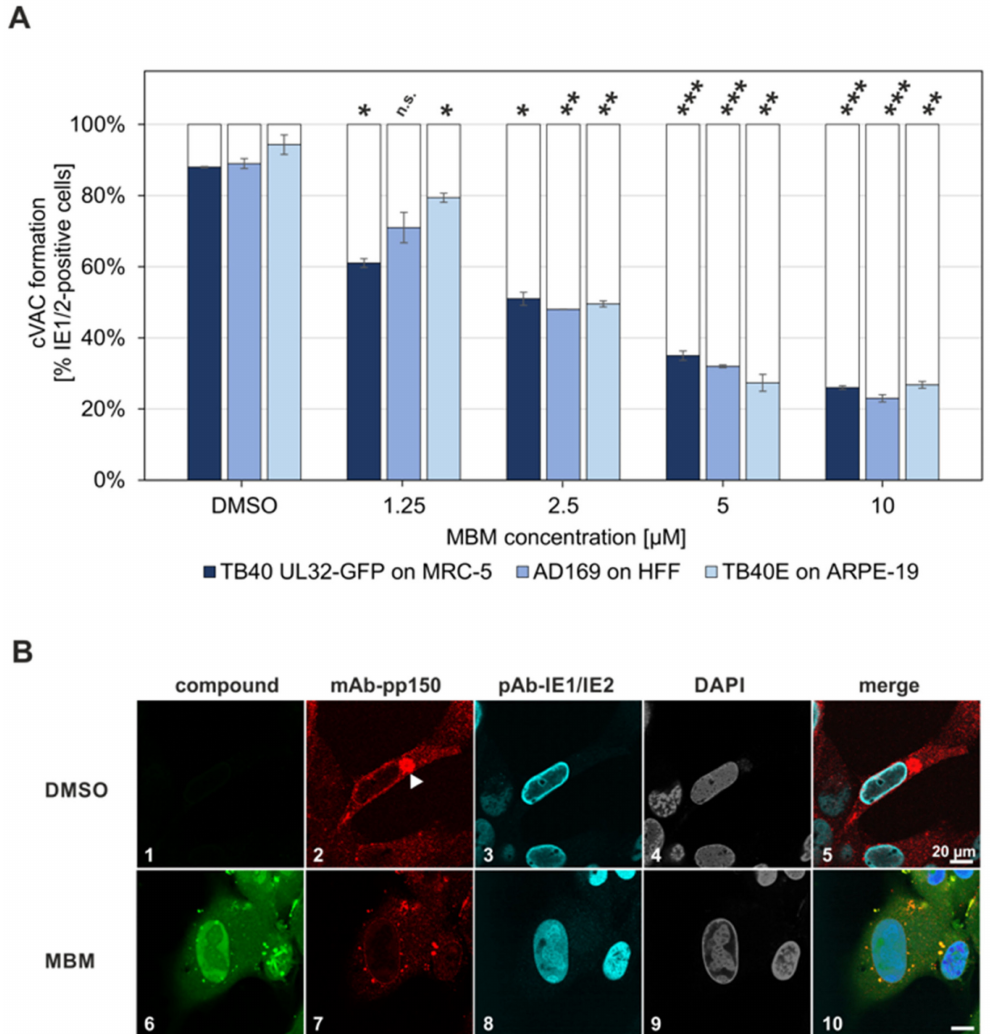
Figure 10. Confocal microscopic evaluation of pp150-positive cVAC formation in HCMV-infected cells in the absence or presence of MBM treatment. ( A ) Three different human cell types, namely MRC-5, HFF and ARPE-19, were cultivated in 6-well plates on cover slips and used for the infection with three different strains of HCMV (MOI ≤ 0.1) and fixed at 5 d p.i. Indirect immunofluorescence staining was performed for viral pp150 (pUL32), representing a marker of viral cVAC formation, and IE1/IE2 proteins, used as an infected-cell control. Nuclear counterstaining was additionally performed